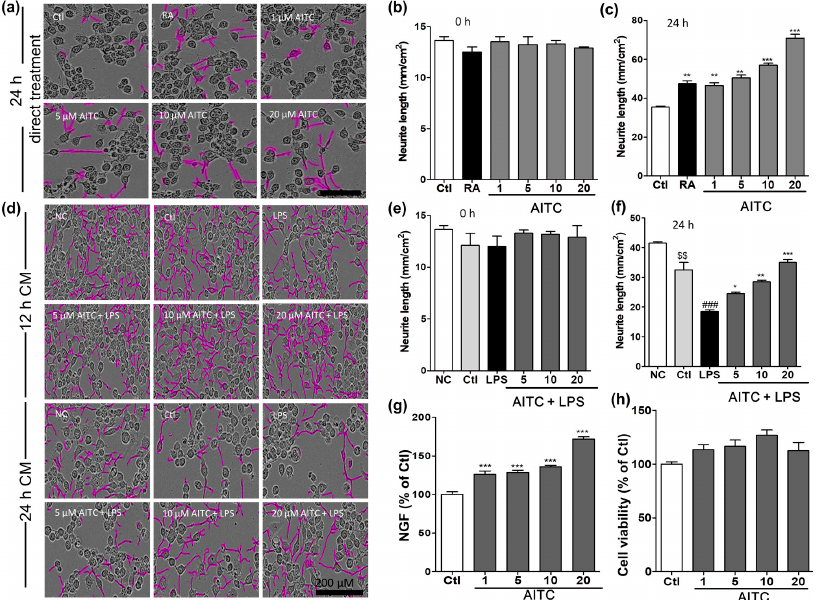
Figure 6. Effects of AITC on neurite morphology and neurite outgrowth in N2a cells and nerve growth factor (NGF) production and viability in C6 glioma cells. Neurite length in N2a cells was measured at regular intervals over 24 h after AITC treatment (1, 5, 10, 20 µ M), and images of the cells were captured at the end of 24 h. ( a ) Neuronal cell morphology after treatment with AITC only. Neurite outgrowth is shown in pink; ( b ) Neurite length before AITC treatment; ( c ) Neurite length after 24 h of AITC treatment. Retinoic acid (10 µ M) treatment was used as the positive Ctl. BV2 cells were treated with AITC 30 min prior to LPS activation, and incubated for 24 h with AITC and LPS treatment. The next day, the CM of AITC- and LPS-treated BV2 cells was transferred to N2a cells and incubated to IncuCyte immediately. Neurite lengths as neurite outgrowth pictures were measured at every 2 h interval starting from 0 h; ( d ) N2a cell morphology after activated BV2 CM treatment; ( e ) Neurite length at 0 h of CM treatment; ( f ) Neurite length after 24 h of CM treatment. C6 cells were treated with AITC for 24 h, the CM was collected for the ELISA of NGF production, and the cell viability assay was performed in the treated cells; ( g ) NGF production in C6 glioma cell as representative cells of astrocyte; ( h ) Viability of C6 cells after AITC treatment. The data shown represent the mean ± SEM of three independent experiments performed, with n = 3. * p < 0.5, ** p < 0.01 and *** p < 0.001 vs. LPS-treated group, $$ p < 0.01 vs. NC group, and ### p < 0.001 vs. Ctl CM group. Ctl: control, RA: Retinoic acid; NC: normal control, and CM: conditioned medium; µ M concentration was